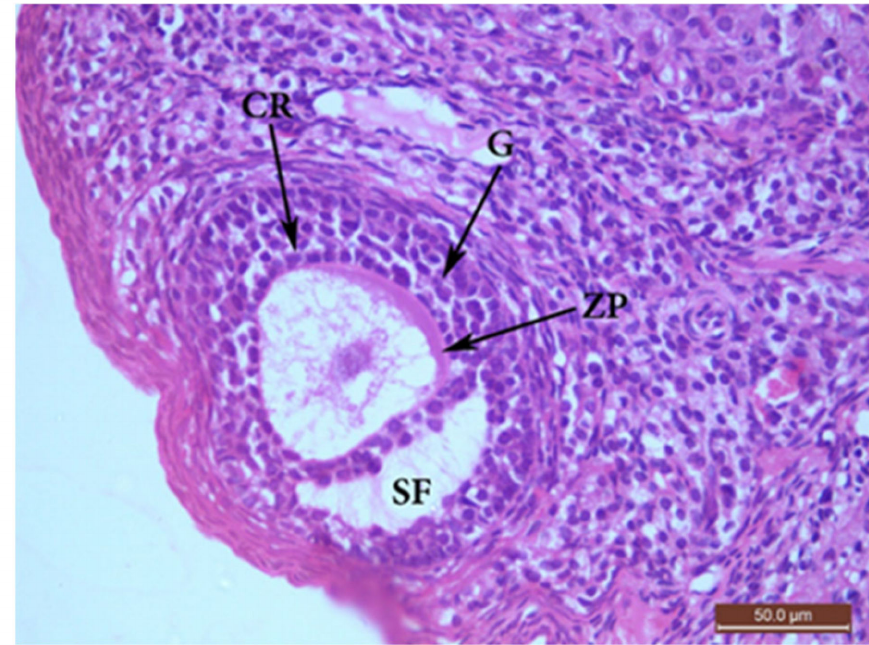
Figure 3. H&E × 400 Photomicrograph from G I ovary. Ovarian section from G I rat at x400 magnification showing a secondary follicle (SF) consisting of a big oocyte with obvious nucleus surrounded by corona radiata (CR) overlying a zona pellucida (ZP), multiple layers of granulosa (G) cells with a fluid cavity. The SF is also surrounded by flat stromal